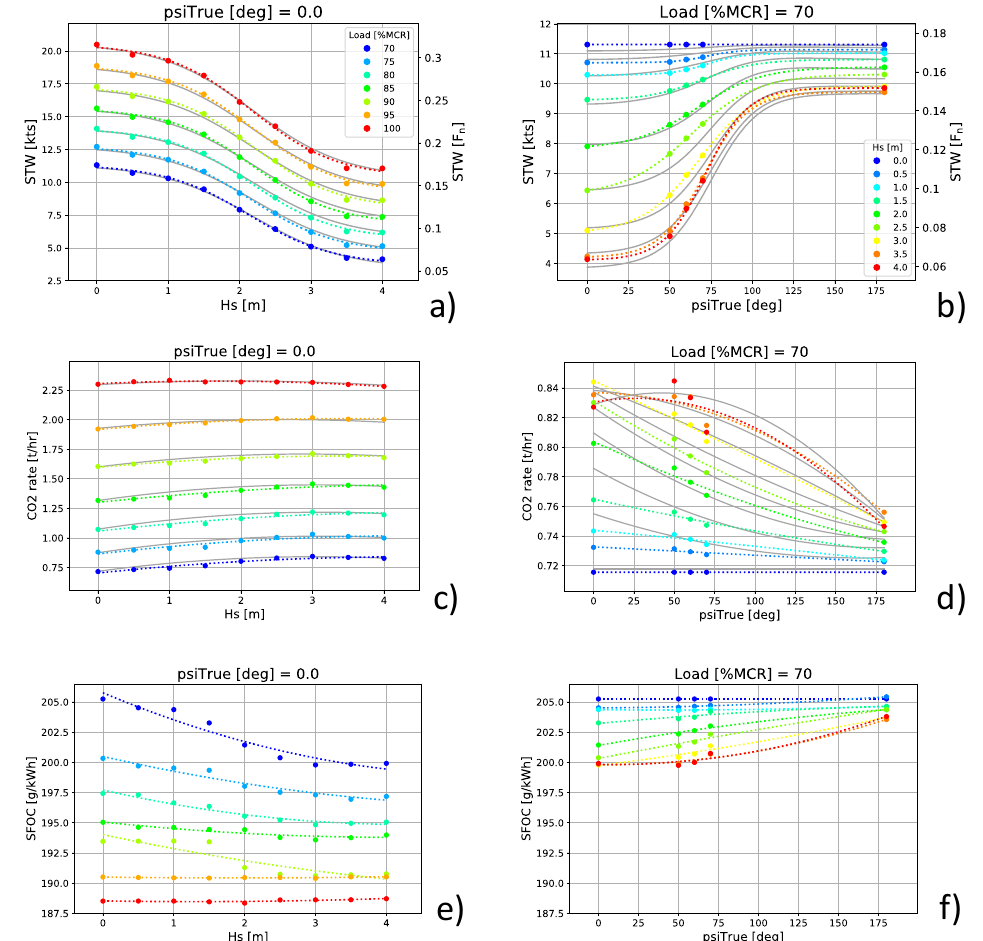
Figure 1. Slices of the multidimensional response function of the vessel of Table 3 collected at the simulator (dots) compared to 1D fits (colored dotted lines), and to multi-dimensional fits (grey lines). Left column panels: dependences on H s at various loads χ for head seas ( ψ T = 0 o ); Right column: dependences on ψ T at various H s for χ = 70%. ( a , b ) STW, given both in knots and in terms of the Froude number F n ; ( c , d ) dCO 2 /dt; ( e , f ) SFOC. It should be minded that the vertical scale of panels in both columns is different but for the bottom